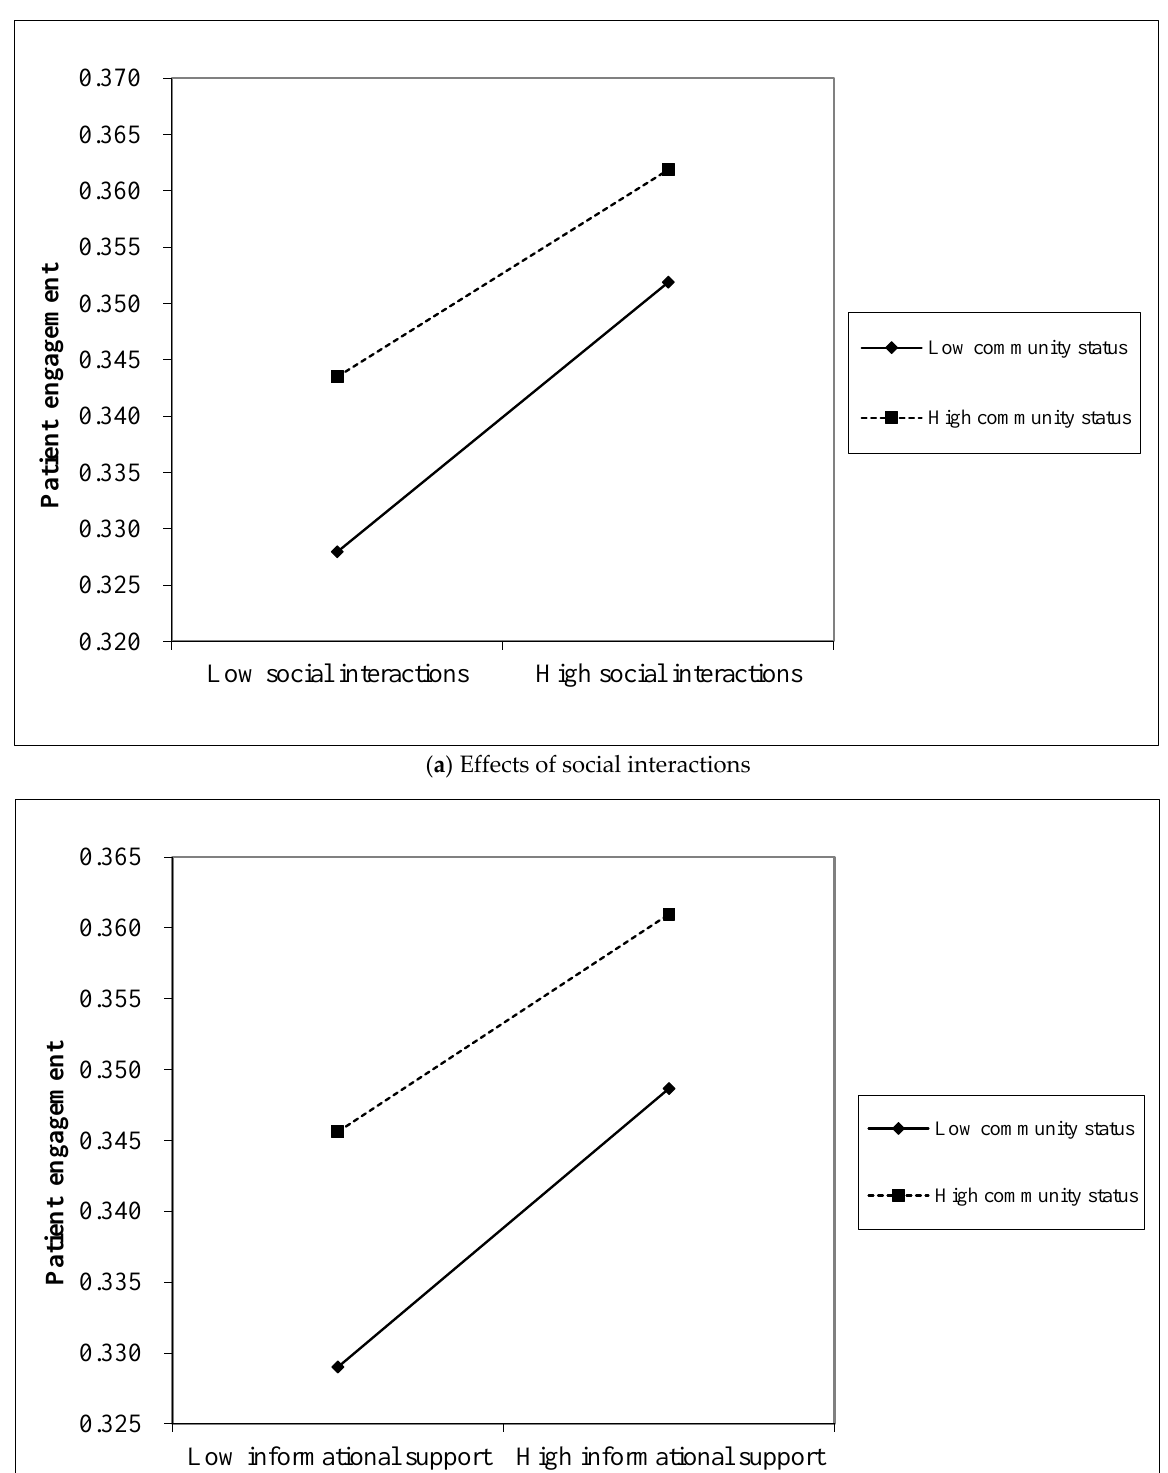
Figure 4. Moderating effects of community status.